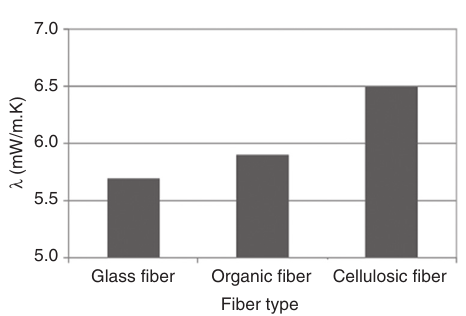
Figure 7 Thermal conductivity coefficient change of VIP according to fiber type.